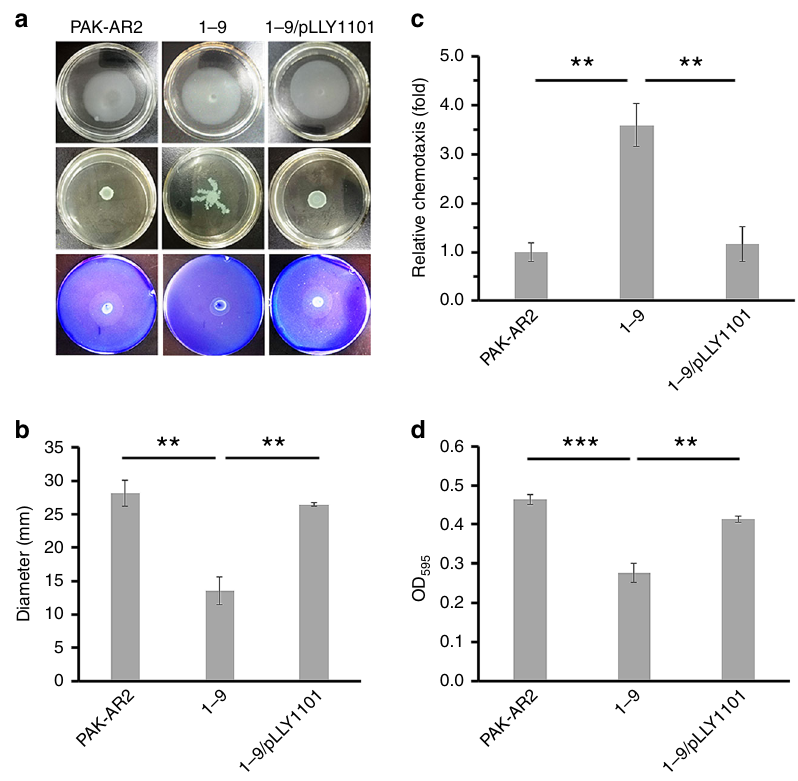
Fig. 5 Assays for motility, chemotaxis, and bio fi lm formation. a Motility tests for PAK-AR2 (left), 1 – 9 (middle), and 1 – 9/pLLY1101 (right). Upper panel: swimming assay. Middle panel: swarming assay. Lower panel and ( b ) twitching motility assay. c Chemotaxis activity evaluation of cell response to the induction by casein hydrolysates. d Bio fi lm formation assay. pLLY1101 carries the srpA gene. Triplicates of each samples were tested. The experiments were independently replicated three times. One-way ANOVA was used to examine the mean differences between the data groups. ** P < 0.01. *** P < 0.001. Error bars show standard